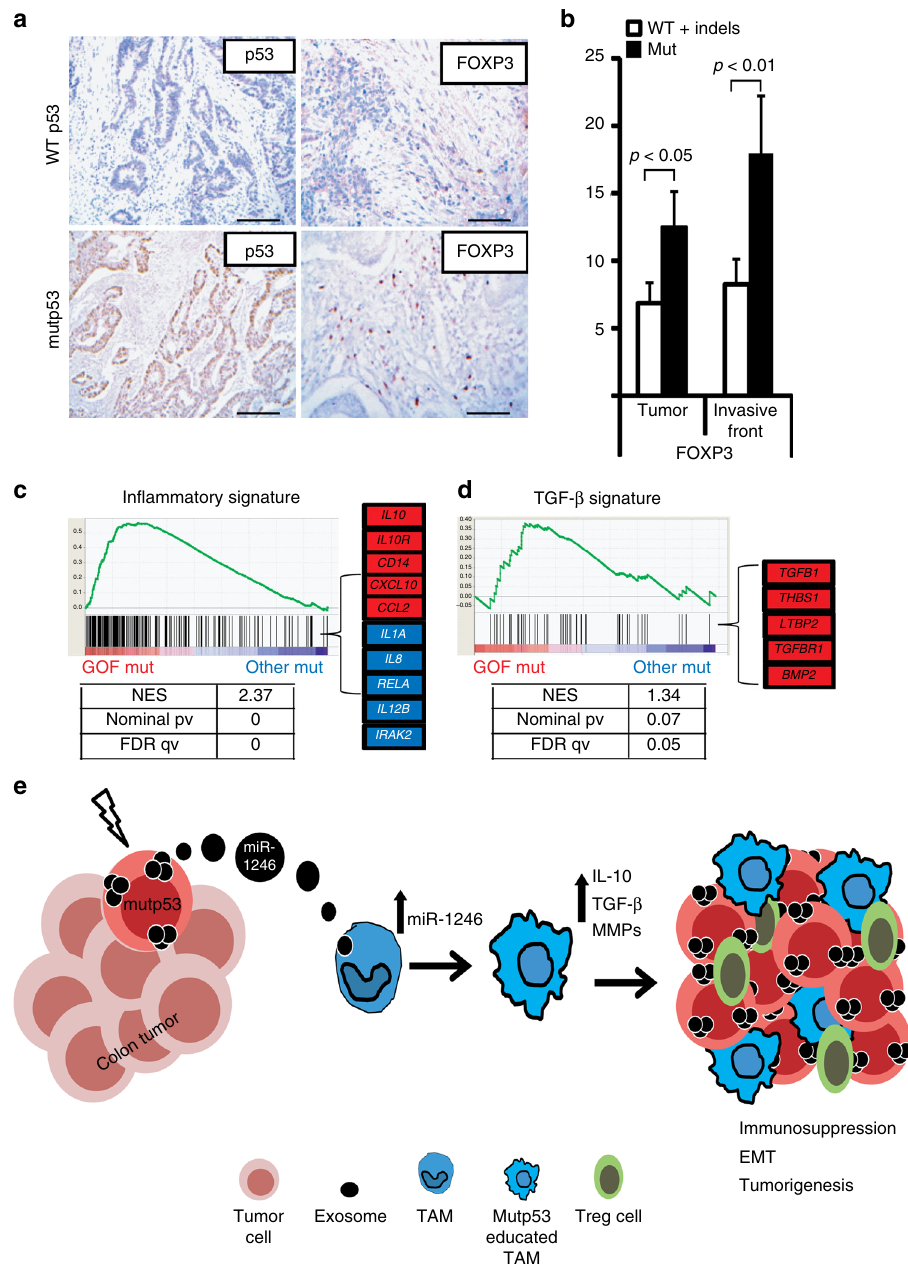
Fig. 7 Increased TGF- β signaling and immunosuppression in mutp53 CRC patients. a Strong epithelial immunostaining of p53 is correlated with strong non- epithelial immunostaining of FOXP3 in a representative human CRC case carrying mutp53 and compared with a WT p53 case. b FOXP3 staining abundance and intensity was calculated for all specimens as described in the Methods section. c , d A general in fl ammatory gene set ( c ) and hallmark TGF- β